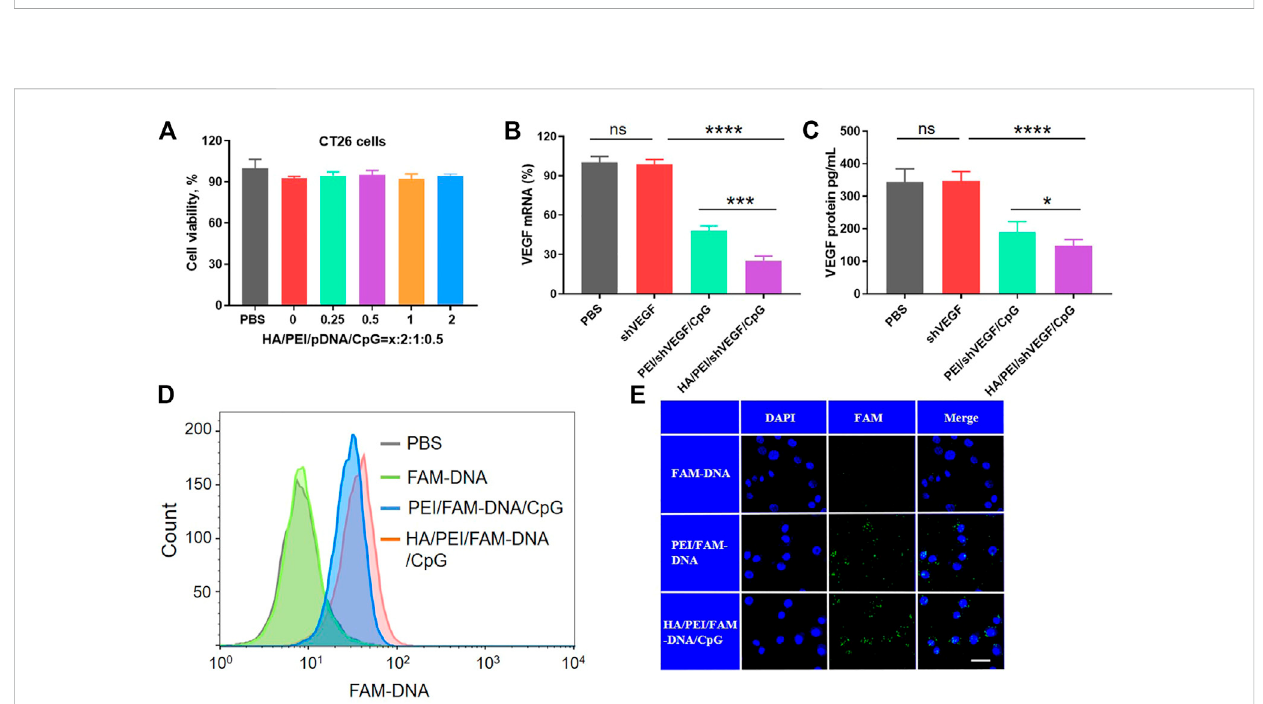
FIGURE 2 Cellular characterizationofHA/PEI/pDNA/CpG nanoparticlesinCT26 cells. (A) CellviabilityofHA/PEI/pDNA/CpG nanoparticlesatvarious contents ofHA. (B) VEGFmRNAexpressionaftergenetransfectionbyRT ‒ qPCRassay. (C) ThesecretionofVEGFlevelsinculturemediumweremeasuredbyELISA kit 48 h after transfection in CT26 cells. (D) Cell endocytosis ef fi ciency of HPDC, PDC and FAM-DNA after 3 h of incubation in CT26 cells by fl ow cytometric analysis. (E) The intracellular uptake of HPDC, PDC and FAM-DNA after 3 h of incubation in CT26 cells by CLSM. The scale bar is 20 μ m ns = no signi fi cance, * p < 0.05, ** p <